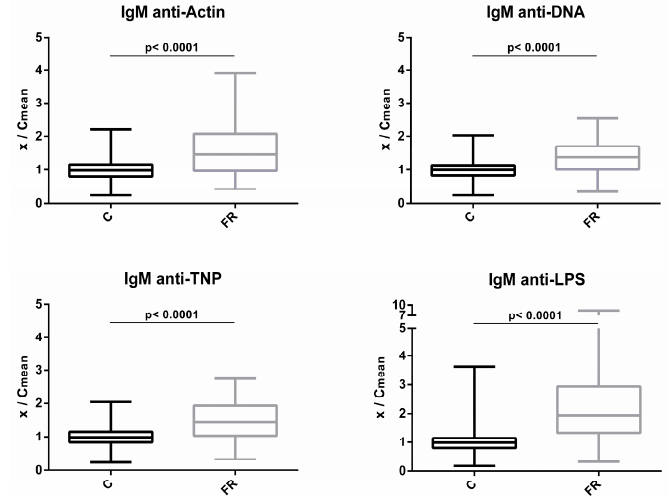
Figure 1. Comparison of IgM NAb levels between fast ‐ and slow ‐ growth broilers: gM NAb levels were estimated by the binding capacity of serum NAbs to actin, DNA, TNP and LPS. On the y axis, values are given as a ratio of individual NAb levels relative to the mean NAb levels of the control group [y = OD(x)/meanOD(C)].